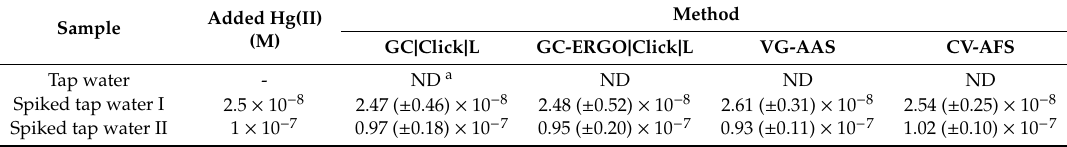
Table 4. Determination of Hg(II) in tap water using GC | click | L and GC-ERGO | click | L modified electrodes. For comparison, Hg(II) concentrations were also determined using standard AAS and AFS methods.